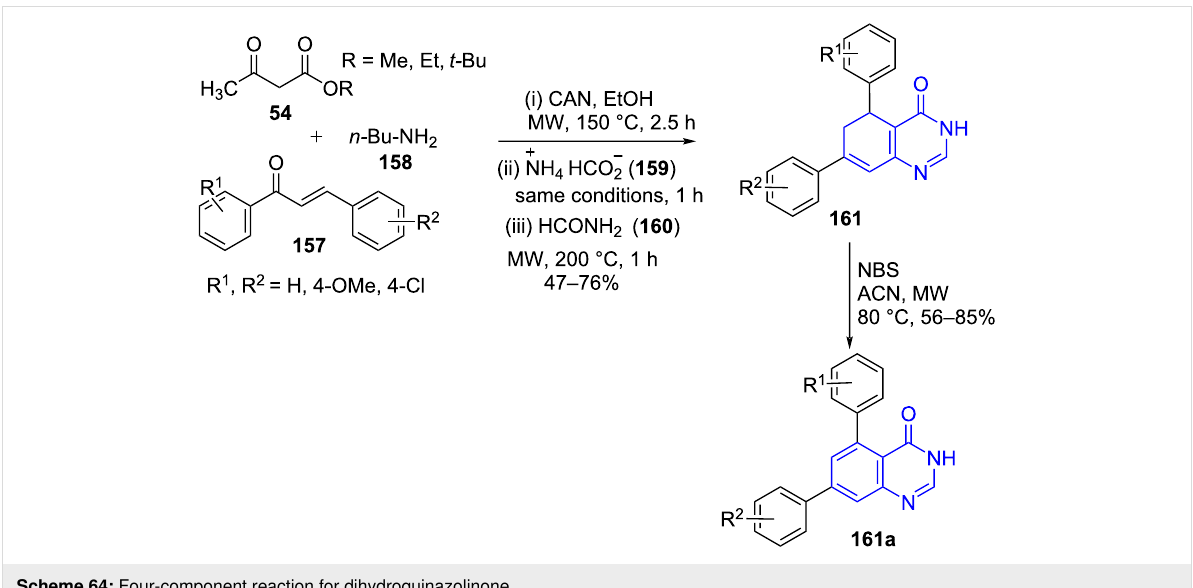
Scheme 64: Four-component reaction for dihydroquinazolinone.